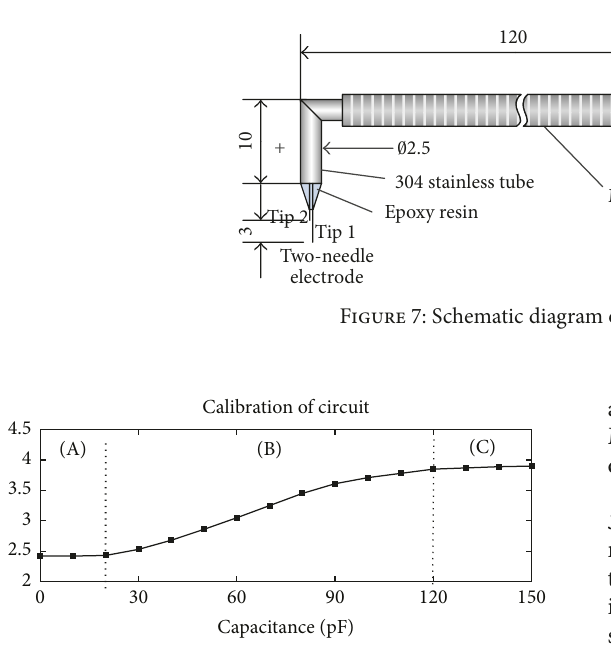
Figure 8: Circuit calibration with a fixed